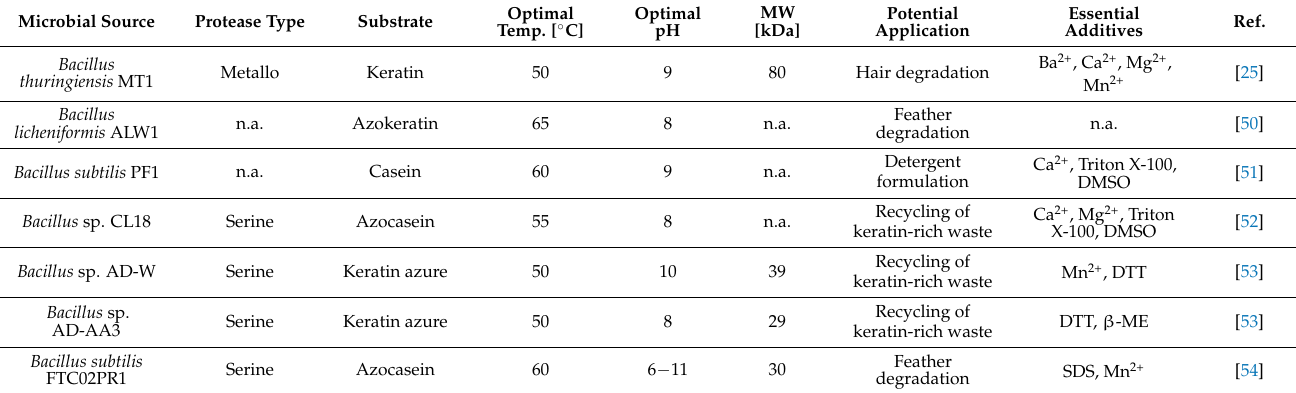
Table 3. Biochemical properties and potential applications of recently isolated keratinolytic enzymes (examples from 2016 to 2021). Microbial